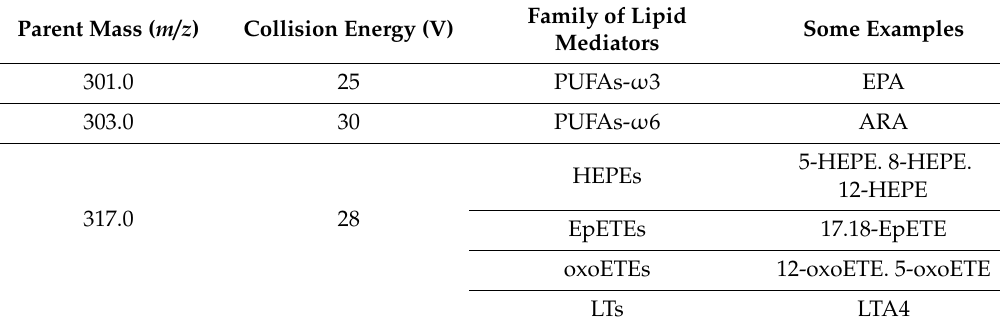
Table 5. MS / MS conditions of the non-targeted LC-MS / MS method developed. More than 100 compounds were classified in 22 groups according to the m / z of their parent ions in negative ESI. Compromise collision energies used for each m / z are shown. The families of lipid mediators studied in each parent mass of the method are indicated as well as some examples of